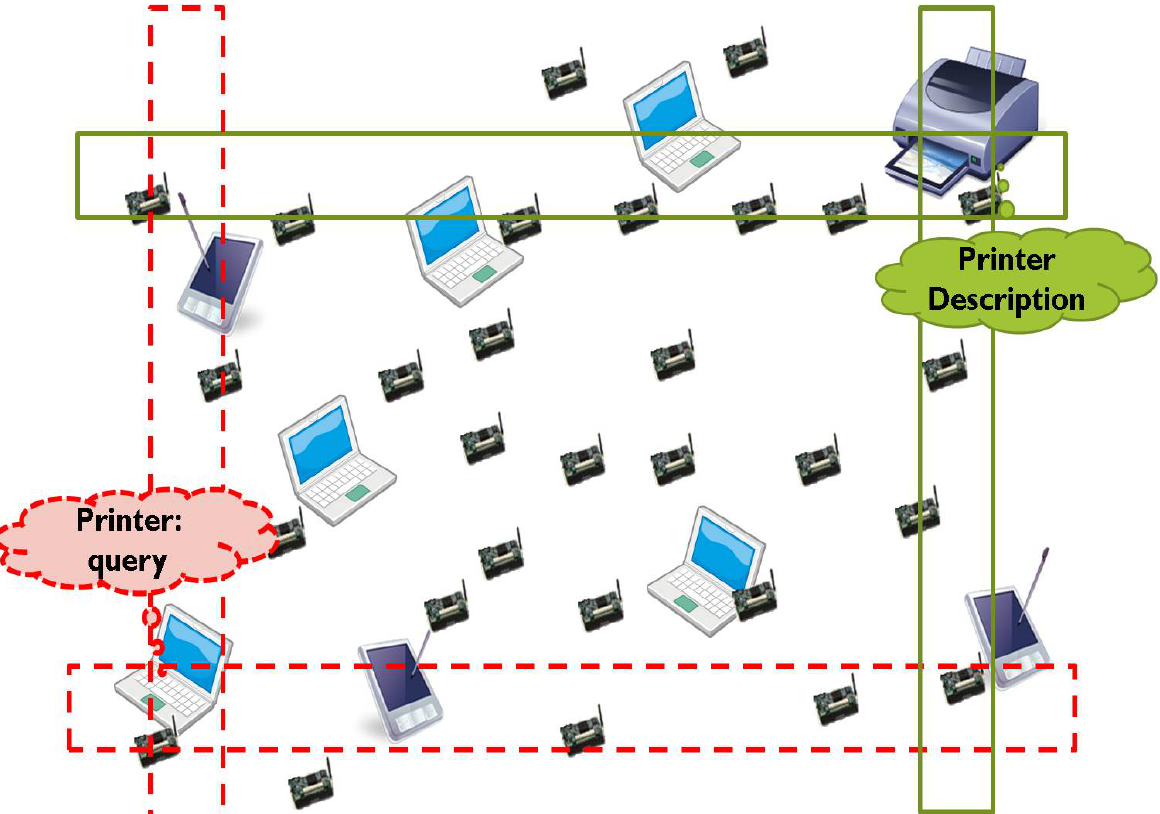
Figure 1. Service location in